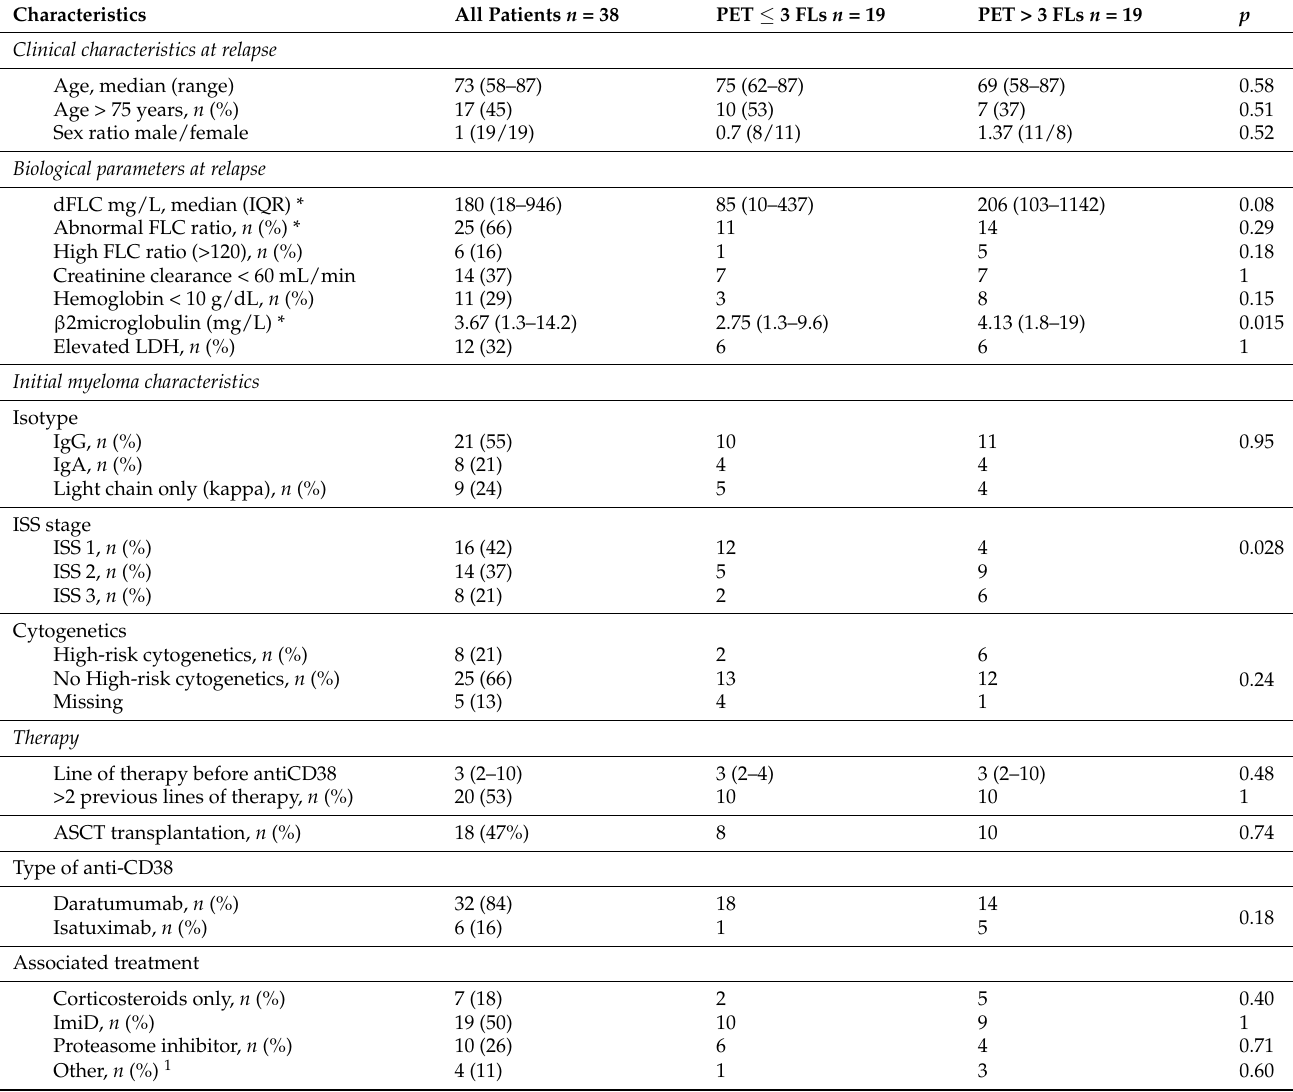
Table 1. Patients characteristics ( n = 38), for the whole cohort and according to the presence of ≤ 3 FLs or >3 FLs on PET/CT. Characteristics All Patients n = 38 Clinical characteristics at